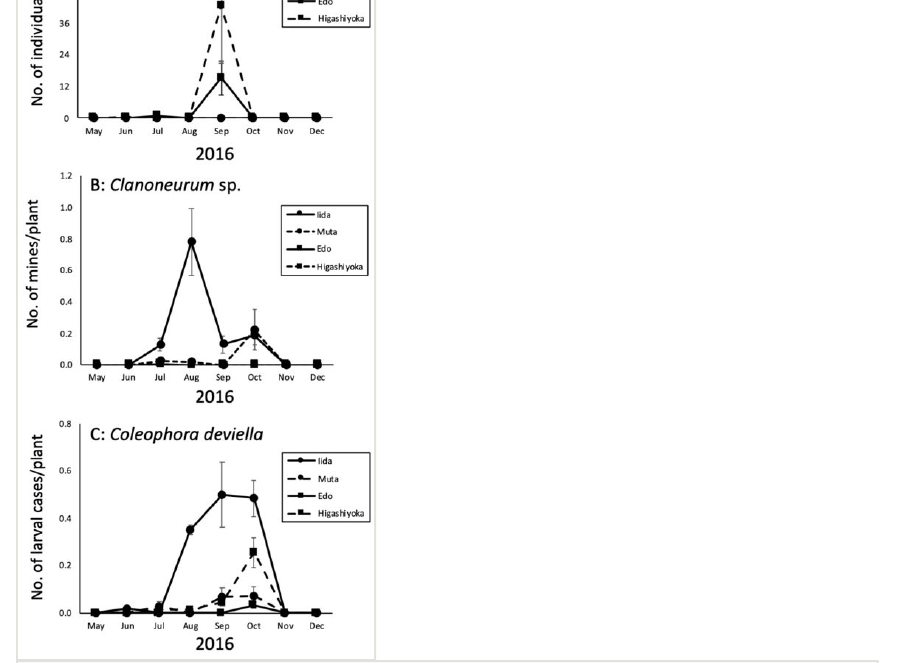
Seasonal changes in densities of major insects on Suaeda . A Seasonal changes in the number of Aphis sp. individuals (per plant) on Suaeda plants in 2016; B Seasonal changes in the number of mines (per plant) produced by Clanoneurum sp. larvae on Suaeda plants in 2016 and C Seasonal changes in the number of larval cases (per plant) formed by Coleophora deviella on Suaeda plants in